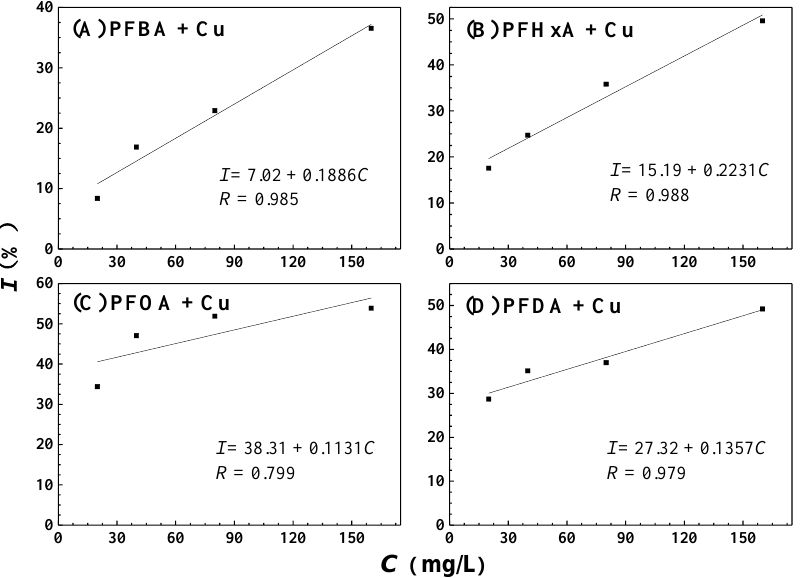
Figure 5. Dose-response relations for joint toxicities of PFCAs and copper. Table 2. Effect of combined exposure to PFCAs and copper in k , I , and IC 50.